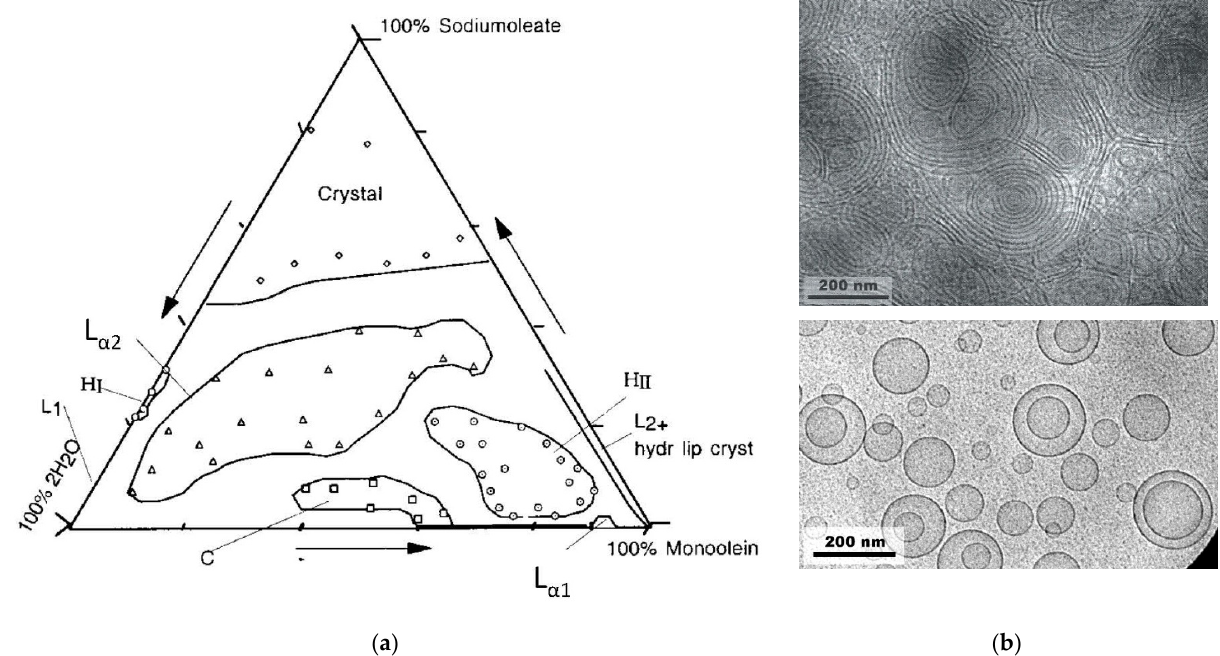
Figure 7. Aqueous mixtues of sodium oleate and monoolein. ( a ) Ternary monoolein/sodium oleate/water phase diagram for T = 25 °C, as presented by Borné et al. (2001) [81]. For the situations represented on the base lines between the water and the sodium oleate corner and between the water and the monoolein corner of the triangle, see Figures 3a and 6a, respectively. The lamellar phase localized close to the monoolein corner is abbreviated as L α 1 . ( b ) Cryo-TEM images of the lamellar phase (L α = L α 2 , appearing as multilamellar vesicles), as present in a sample consisting of 10 wt% monoolein, 5 wt% sodium oleate, and 85 wt% water ( top ) [81]; and of dispersed vesicles present in a sample consisting of 0.2 wt% monoolein, 1.8 wt% sodium oleate, and 98 wt% water ( bottom ) [79]; both samples were quenched from T = 25 °C. Reproduced with permission from [81], American Chemical Society, 2001; and from [79], Elsevier, 2003.